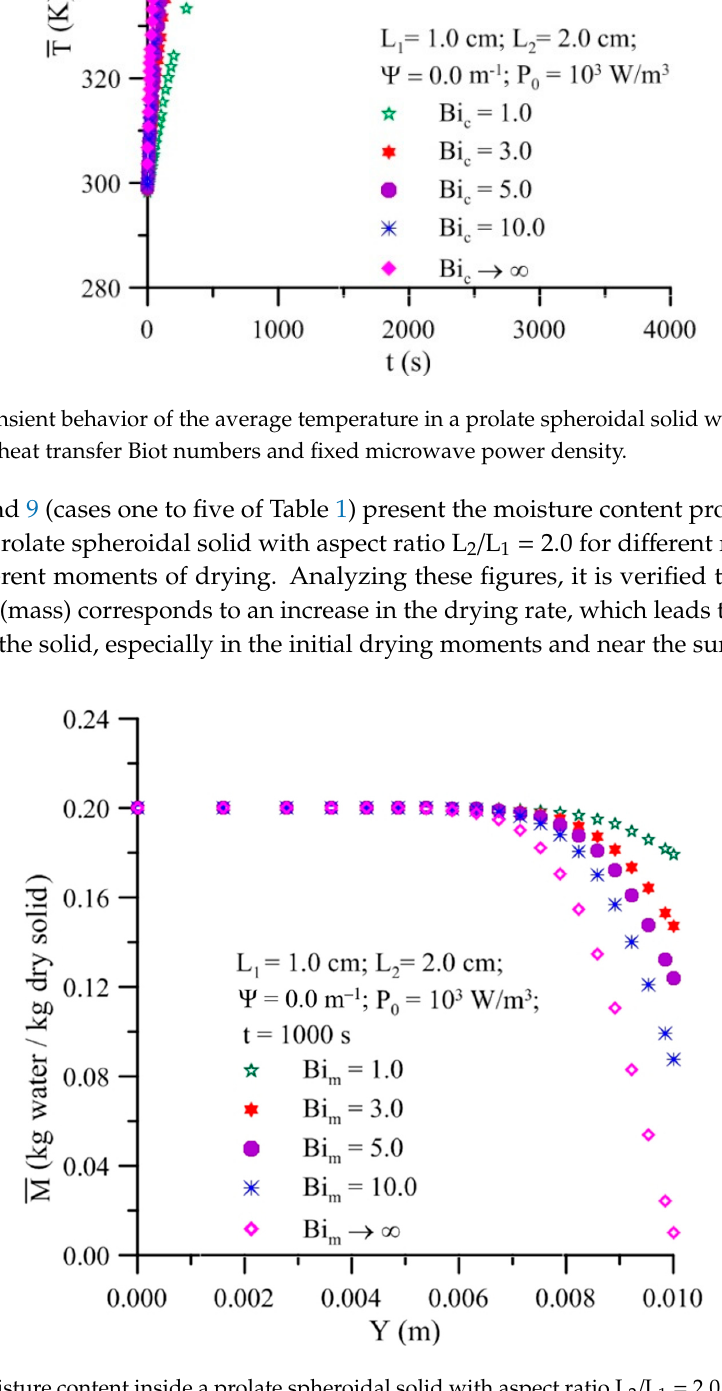
Figure 8. Moisture content inside a prolate spheroidal solid with aspect ratio L 2 /L 1 = 2.0, different mass transfer Biot numbers and fixed microwave power density ( y -axis, z = 0, t = 1000 s).